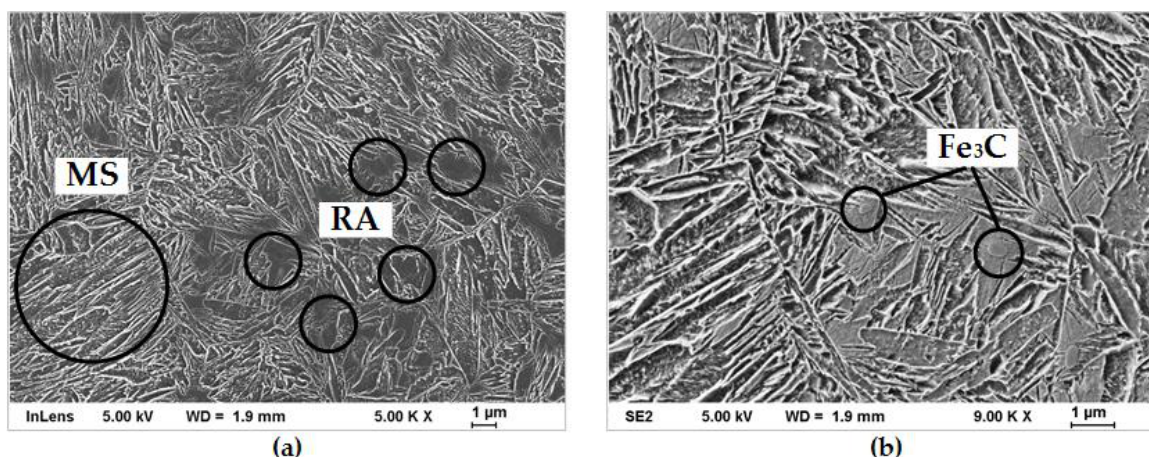
Figure 4. ( a ) Scanning electron microscopic image of QP1; ( b ) detail QP1.